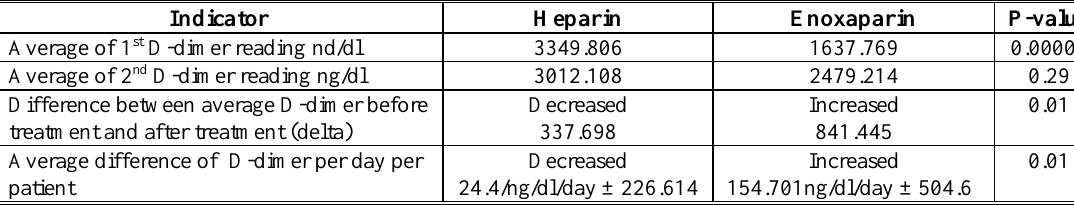
Table 4. The effect of anticoagulant therapies on the level of D-dimer of hospitalized patients with COVID-19.